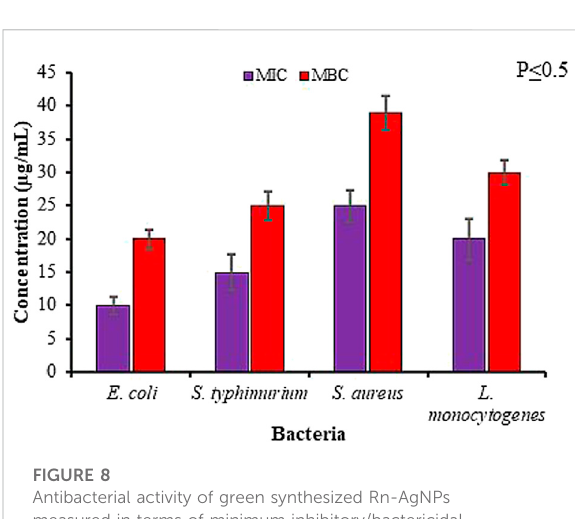
FIGURE 8 Antibacterial activity of green synthesized Rn-AgNPs measured in terms of minimum inhibitory/bactericidal concentration (MIC/MBC) for different bacterial